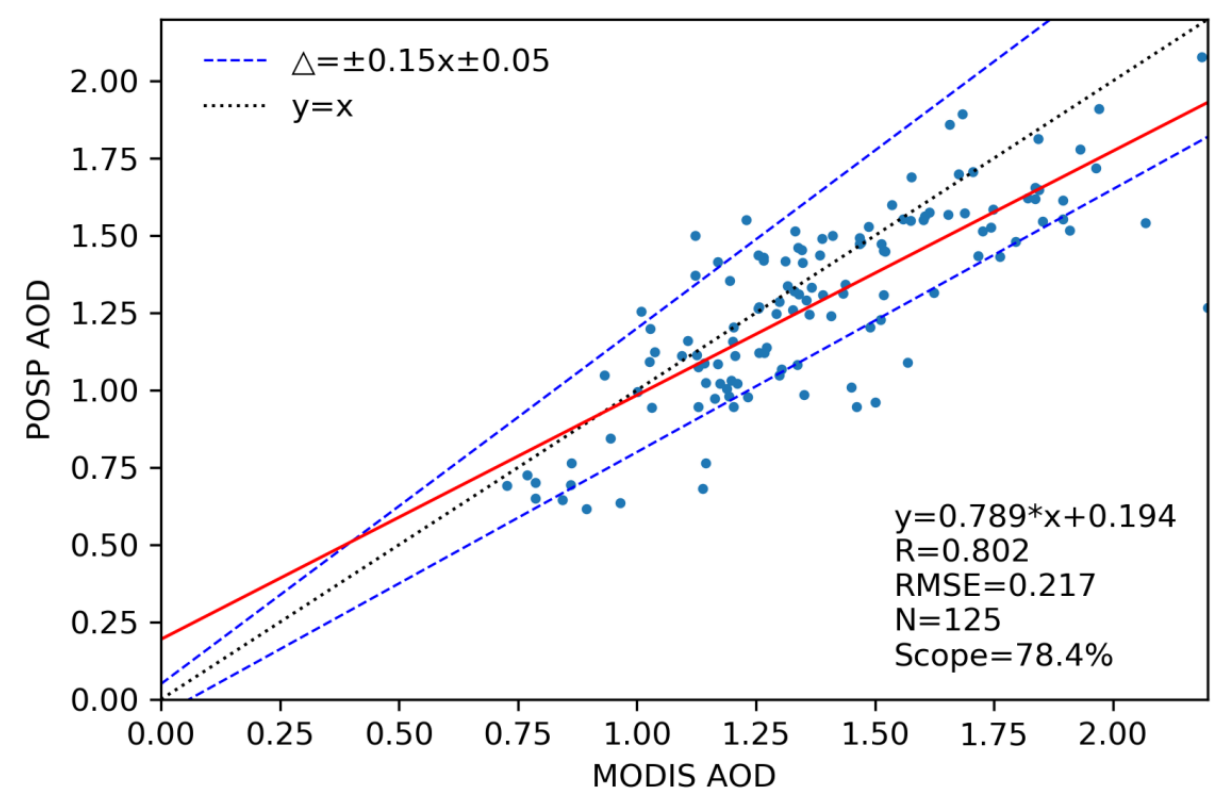
Figure 7. The scatter plot of POSP AOD inversion results against MODIS products (9 June 2022). According to the statistical results of Figure 7, a total of 125 high-value AOD data are obtained, of which 78.4% of the data fall within the error range, and the correlation coefficient R is